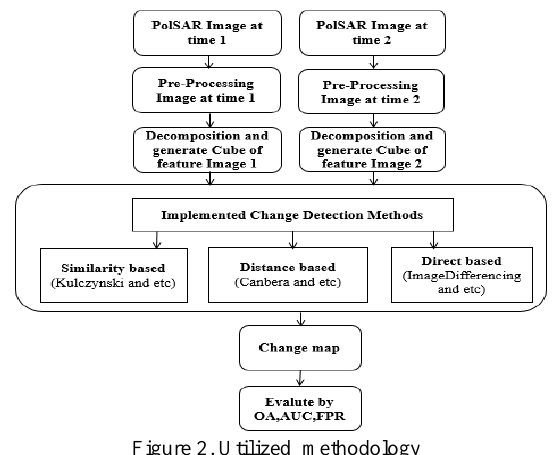
Figure 2. Utilized methodology 4.1 Similarity-base results